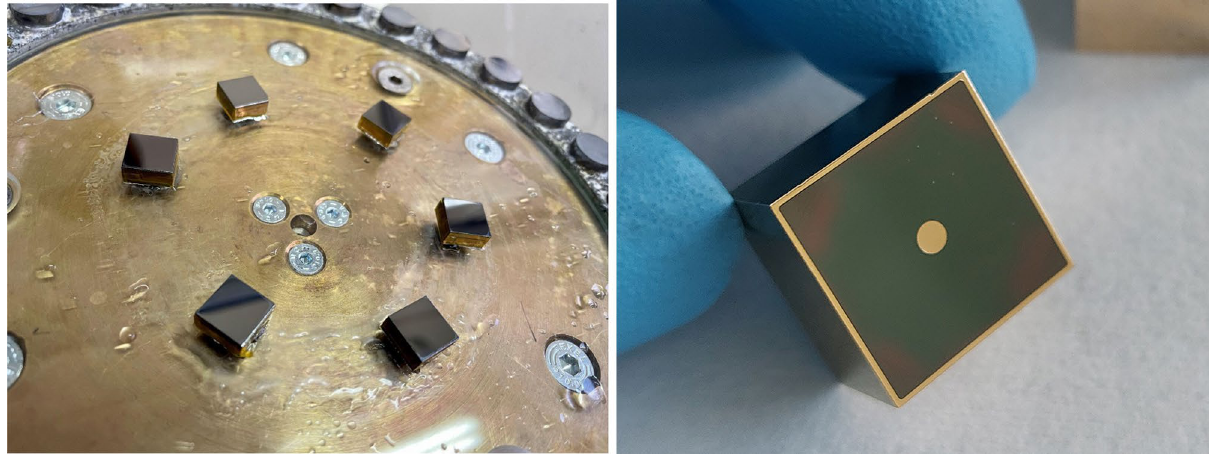
Figure 2. Six 10 × 10 × 5 mm 3 detectors glued on the lapping jig (left); one of the 15 × 15 × 10 mm 3 fabricated detectors